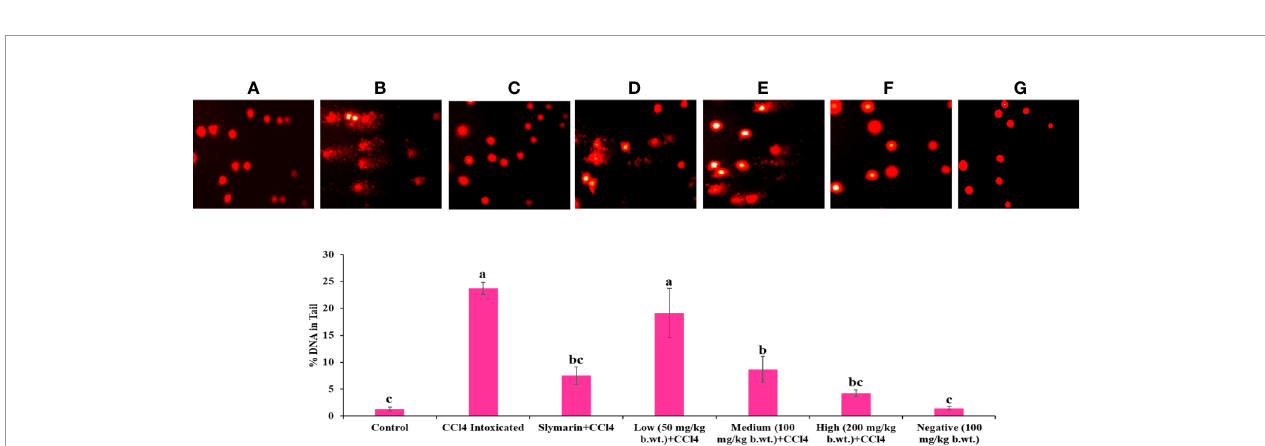
FIGURE 8 | Single cell gel electrophoresis assay was used for determined DNA damage/protect in liver of rats. Results of the comet assay con fi rm that pretreatment with Obeth decreases CCl 4 -induced hepatotoxicity in rats. (A) Control group (tap water ad libitum) (GI), (B) CCl 4 : Olive oil (1:1; 1mL kg -1 b.wt.) in GII, (C) Silymarin (100 mg kg -1 b.wt.) + CCl 4 , (D) low dose (50 mg kg -1 b.wt.) + CCl 4 , (E) medium dose (100 mg kg -1 b.wt.) + CCl 4 , (F) High dose (200 mg kg -1 b.wt.) + CCl 4, (G) Negative (only extract 100 mg kg -1 b.wt.). Histograms showing densitometric analysis of % of DNA in tail in comet assay. Values are expressed as Mean ± SE at level of signi fi cance p ≤ 0.05. Data labels with different letters represent signi fi cant difference among them.